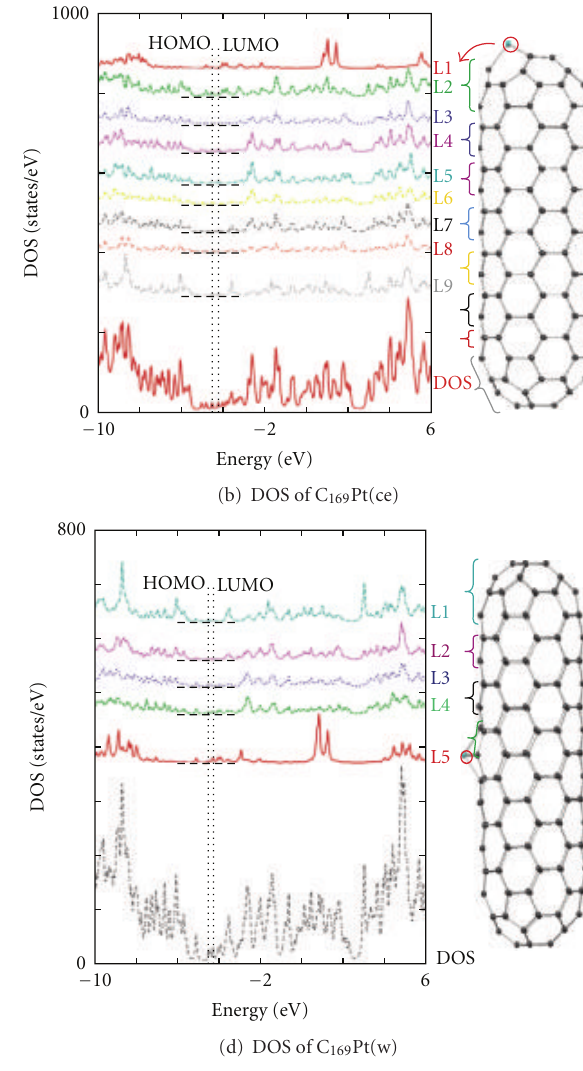
Figure 13: Optimized geometries, DOS, and LDOS of (a) C 170 with D 5 h symmetry ( ε HOMO = − 4 . 61 eV, ε LUMO = − 4 . 26 eV), (b) C 169 Pt(ce) with C s symmetry ( ε HOMO = − 4 . 51 eV, ε LUMO = − 4 . 21 eV), (c) C 169 Pt(c) with C s symmetry ( ε HOMO = − 4 . 48 eV, ε LUMO = − 4 . 25 eV), and (d) C 169 Pt(w) with C s symmetry ( ε HOMO = − 4 . 46 eV, ε LUMO = − 4 . 26 eV). L1 − L9 are the LDOS for each specified layer of atoms as marked on the diagram [35,